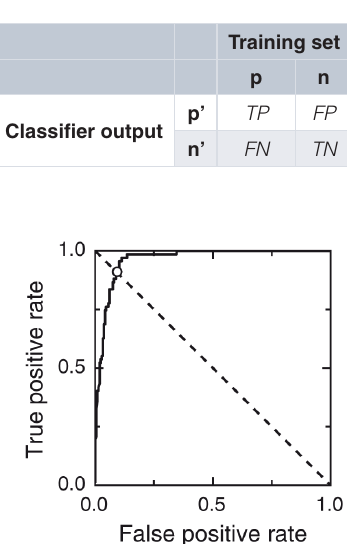
Figure 1. Optimal threshold estimation in ROC space for a binary classifier using game theory. The descending diagonal TPR = 1 – FPR (dashed line) minimizes classifier performance with respect to q . The intersection between the receiver operating P characteristic ( ROC ) curve (continuous line) and this